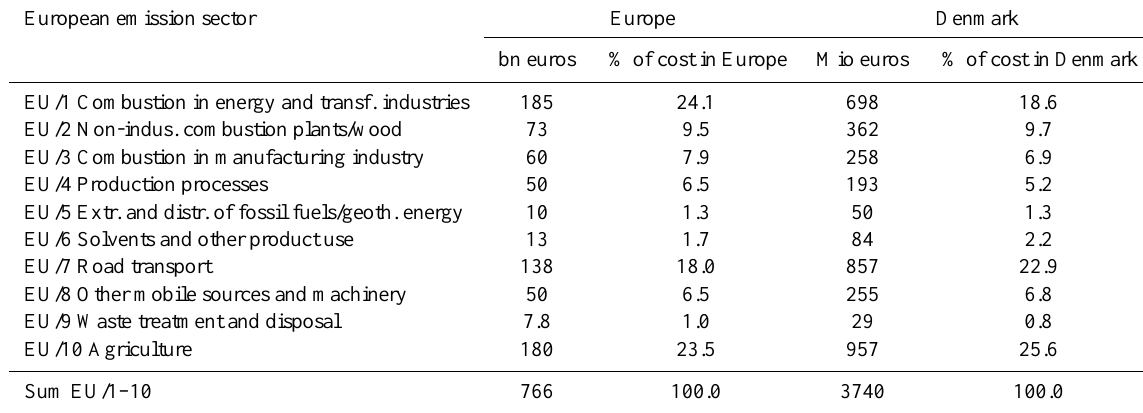
Table 5. Total health-related external costs for Europe (billion euros) and Denmark (million euros) from the 10 major individual emission SNAP categories in Europe (DEHM domain 2) for the emission year 2000 as well as their contributions in % to the total external cost in Europe and Denmark. respectively. All costs are in 2006 prices.